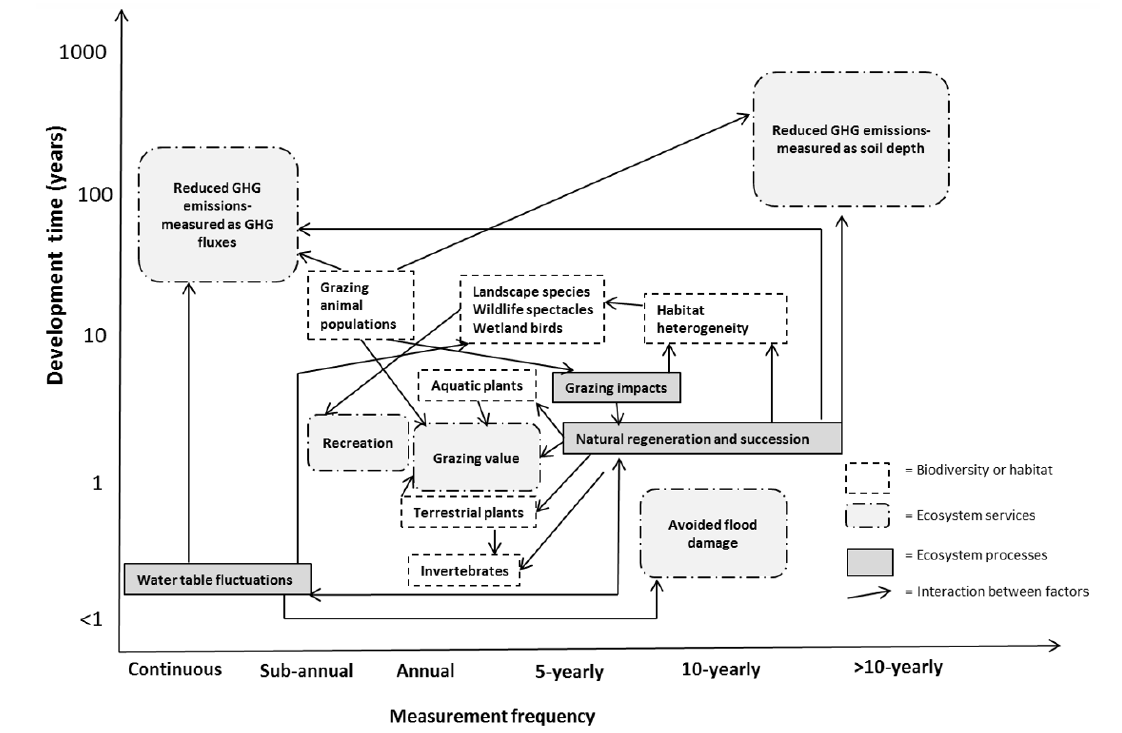
Fig. 1 . Conceptual diagram of monitoring activities at the Wicken Fen Vision project (GHG: greenhouse